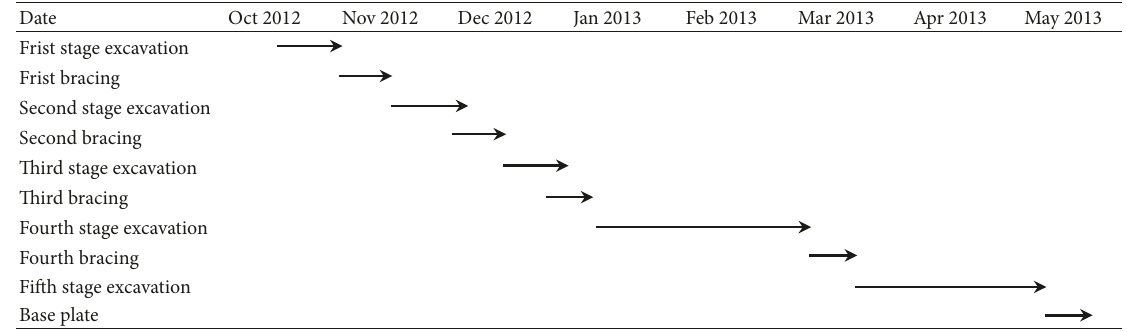
Figure 3: Construction schedule of excavation and bracing.